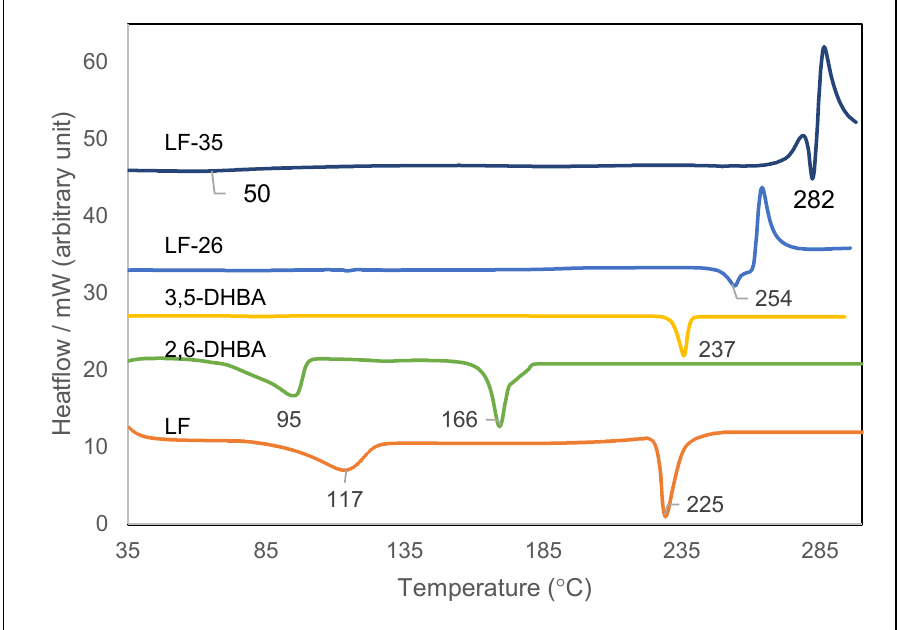
Figure 3. Thermograms of LF-26 and LF-35 from DSC analysis compared to starting materials. Note: LF = levofloxacin (hemihydrate); 2,6 DHBA = 2,6 dihydroxybenzoic acid; 3,5 DHBA = 3,5 dihydroxybenzoic acid; LF-26 = levofloxacin 2,6 dihydroxybenzoic acid multicomponent system, LF-35 = levofloxacin 3,5 dihydroxybenzoic acid multicomponent system.